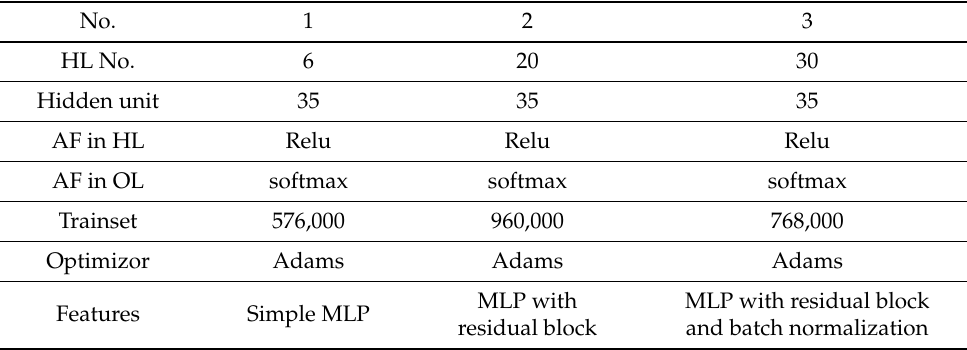
Table 4. Architecture of NNs for classification